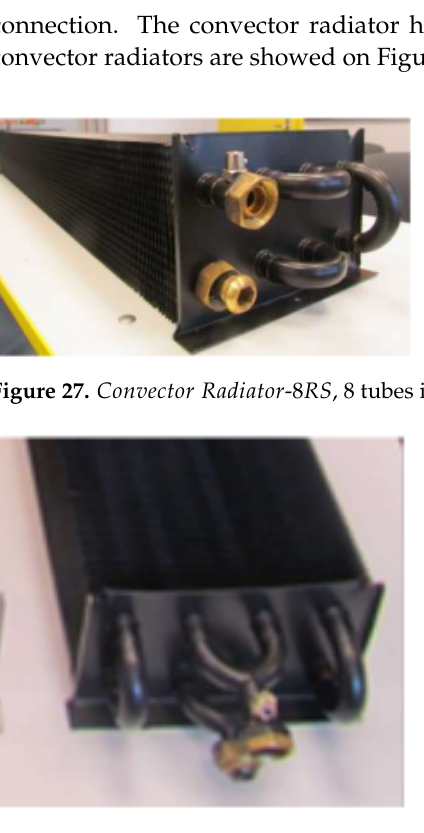
Figure 28. Convector Radiator -8 RR , 8 tubes in parallel connection.